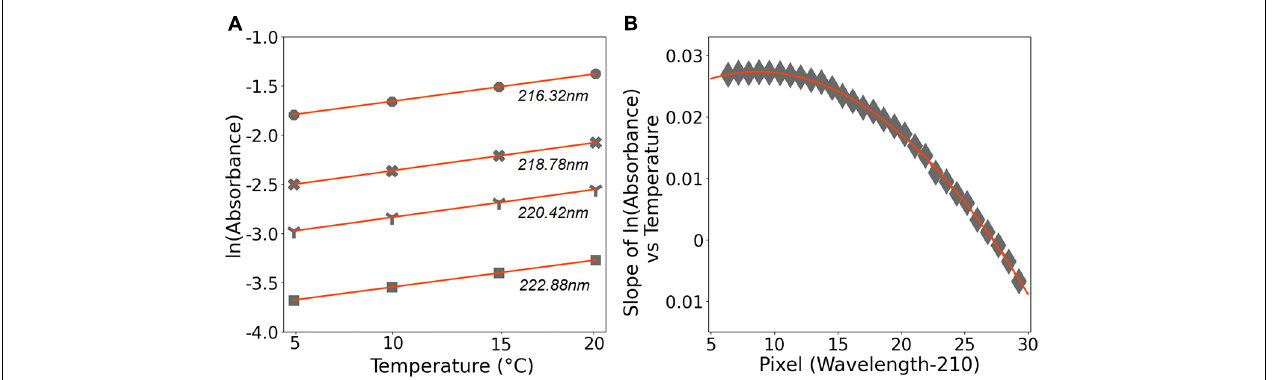
FIGURE 6 | (A) The ln(absorbance) values of 840 µ M Br − solution plotted vs. temperature of the solution; at 216.32, 218.78, 220.42, and 222.88 nm. Data are shown in gray. The solid red lines refer to the linear regression ( r 2 = 0.99), with y = 0.0277 x –1.9323, y = 0.0284 x –2.6439, y = 0.0282 x –3.1159, and y = 0.0271 x –3.8135, respectively. (B) The slope of ln(absorbance) vs. temperature plotted vs. pixel. In here, pixel refers to wavelength –210, within 216 and 239 nm. The solid red line presents the third-order polynomial fit and has y = 1e–07 x 3 –9e–05 x 2 + 0.0016 x + 0.0212, r 2 = 0.99.